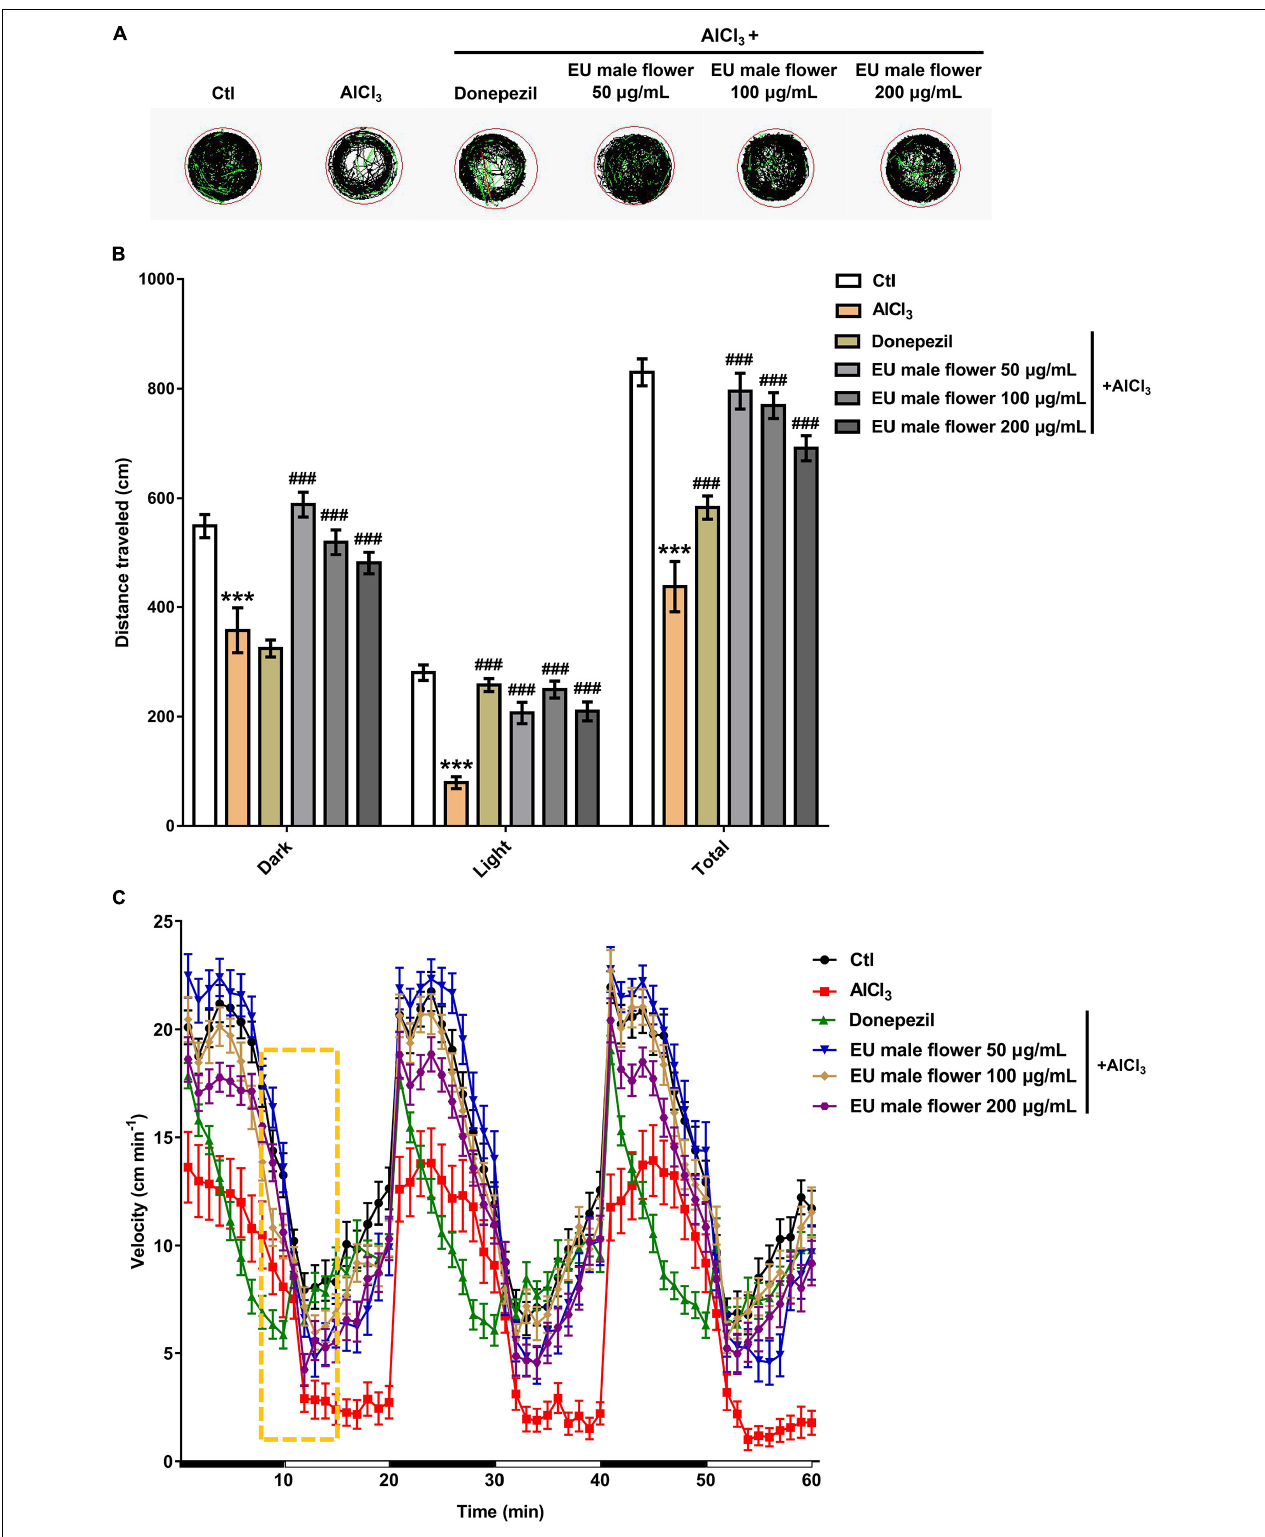
FIGURE 2 | Effect of EUMF on AlCl 3 -induced locomotion impairments in zebrafish. (A) Dgital track map. The red, green, and black lines depict fast, medium, and slow movements, respectively ( n = 10). (B) Total distance moved in the Ctl, AlCl 3 , and AlCl 3 + EUMF groups (*** P < 0.001 vs. Ctl; ### P < 0.001 vs. AlCl 3 ; n = 10). (C) Speed change in the Ctl, AlCl 3 , and AlCl 3 + EUMF groups (the speed change after light stimulus is demarcated by the frame; n = 10).